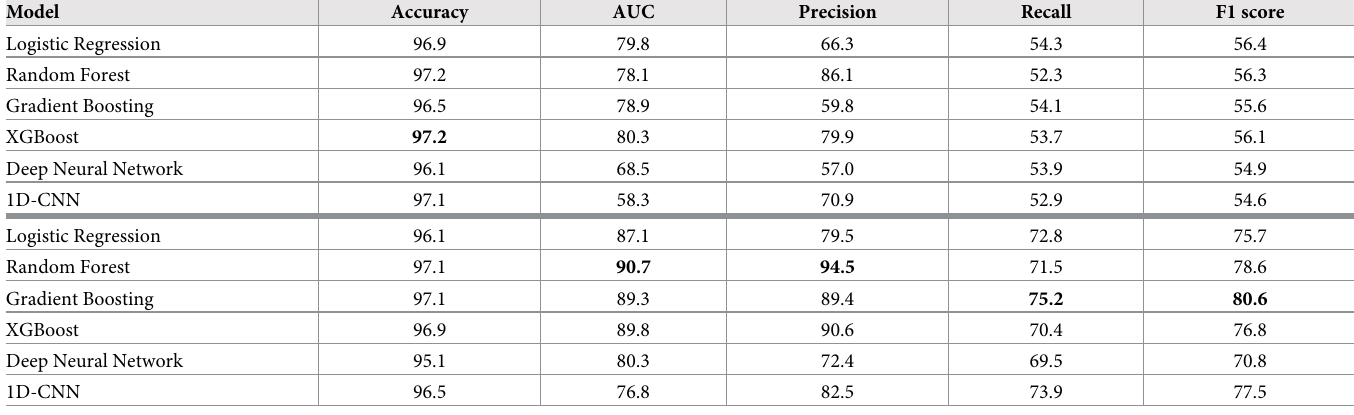
Table 5. Evaluation performance of the original ACS prediction model before/after preprocessing. Model Accuracy AUC Precision Recall F1